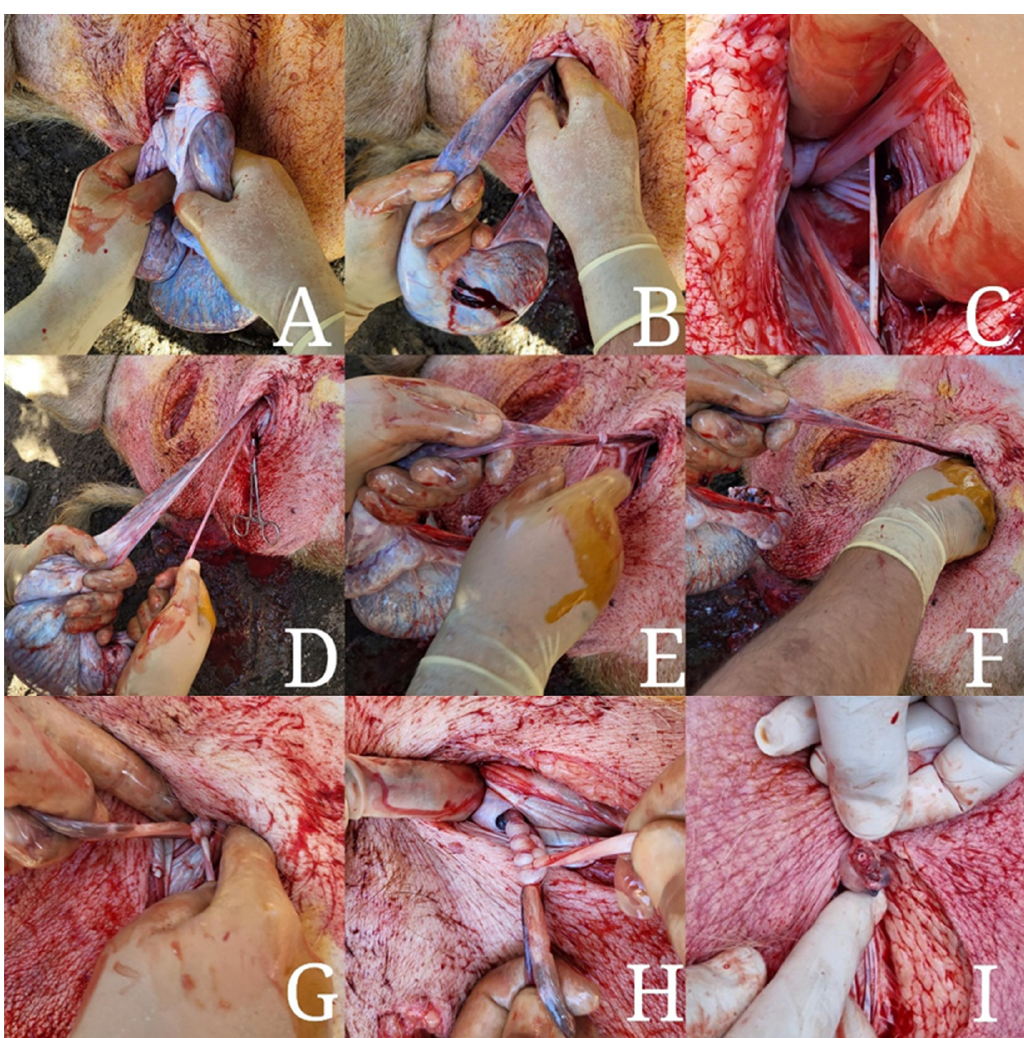
Figure 2. Illustration of orchiectomy using the sutureless technique: Initiate by making a skin incision in the prescrotal area with a scalpel blade. Continue the incision through the underlying tissue and parietal tunica vaginalis and exteriorize the testis ( A ). Digitally rupture the ligament of the tail of the epididymis and strip the spermatic cord from the tunica vaginalis up to the level of the inguinal canal ( B , C ) before manually detaching the deferens duct from the epididymis, splitting the spermatic cord into a spermatic and vascular portion ( D ). Tie both portions together using 4 to 6 simple knots ( E , F ). Place the first knot as proximally as possible to the internal inguinal ring ( G ) and the following knots about 2 cm distally to the first ( H ). Finally, align the spermatic and vascular portions of the spermatic cord and transect using a scalpel blade No 22. Assess that correct haemostasis of blood vessels is achieved ( I